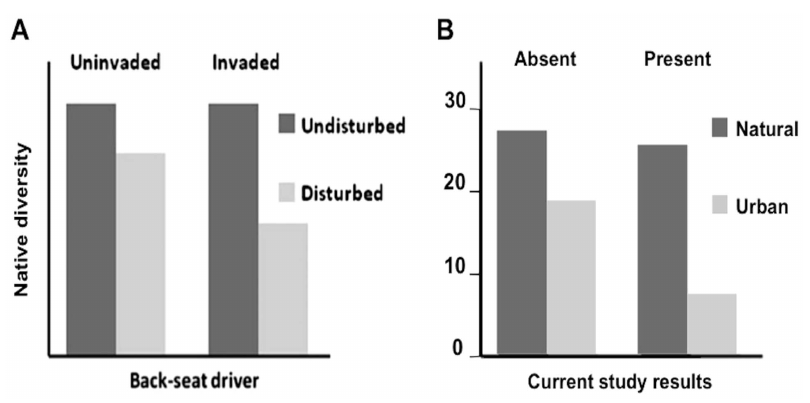
Fig. 3. Comparison of archetypal back-seat driver data to Tapinoma sessile and urbanization influence on ant community richness. Both bar graphs represent studies sampling species richness within undisturbed or disturbed habitat in the presence or absence of an invasive species. ( a ) This chart is copied directly from Berman and Andersen [58] (Fig. 1) using ‘natural experiments’ to visualize data typical of a back- seat driver model. ( b ) The second chart represents total richness data plotted from this study and mirrors the idealized back-seat driver data. Numbers left of the Y-axis represent total species number.